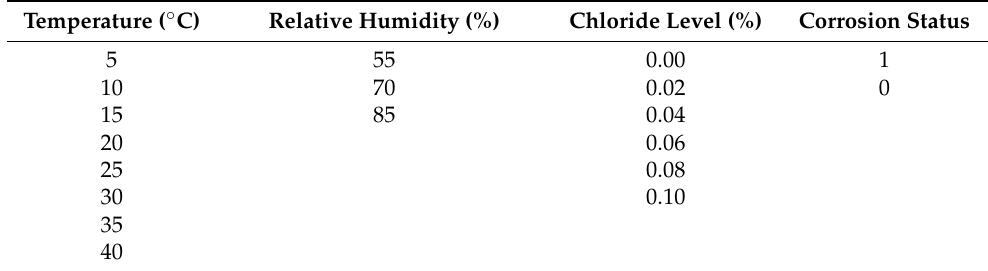
Table 1. Parameters related to GPR data.